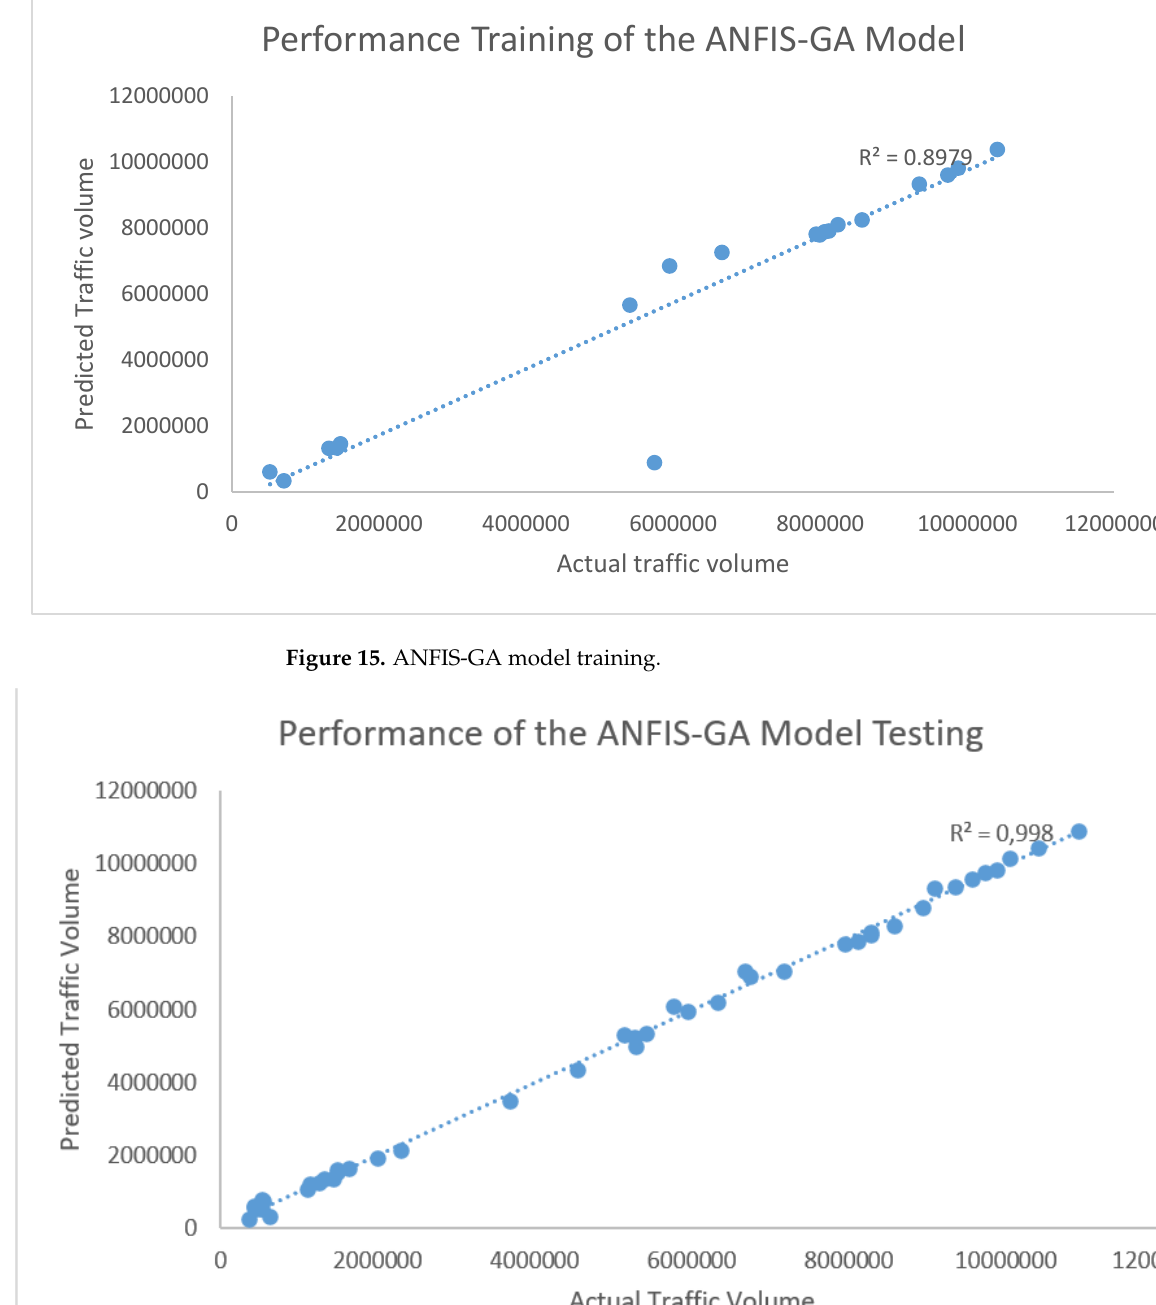
Figure 14. ANFIS-GA model testing with the traffic datasets